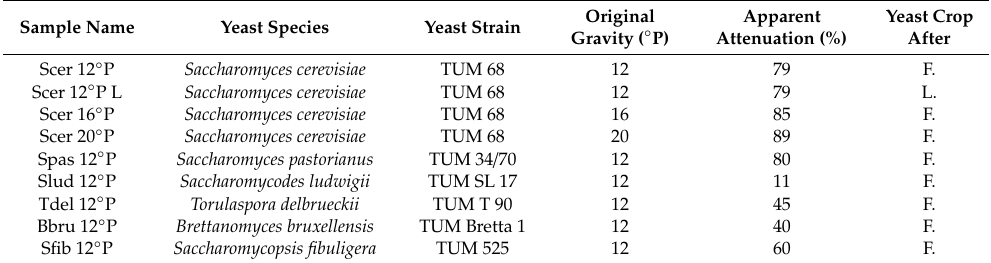
Table 2. Sample overview and process details of cropped surplus yeast after primary fermentation (F.) and cold lagering (L.); data are expressed as mean values; confidence limits were determined to be lower than 5% of the average